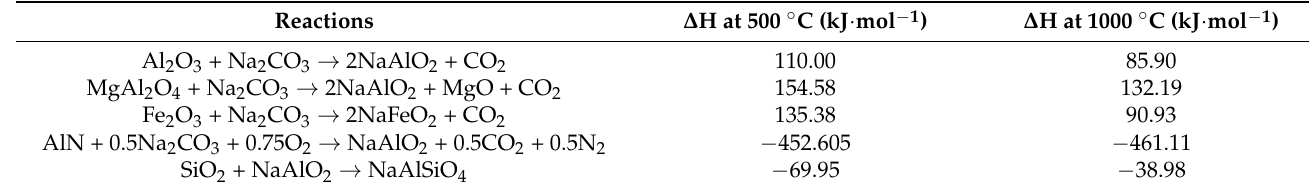
Table 3. Enthalpy changes in the reactions during the roasting process.